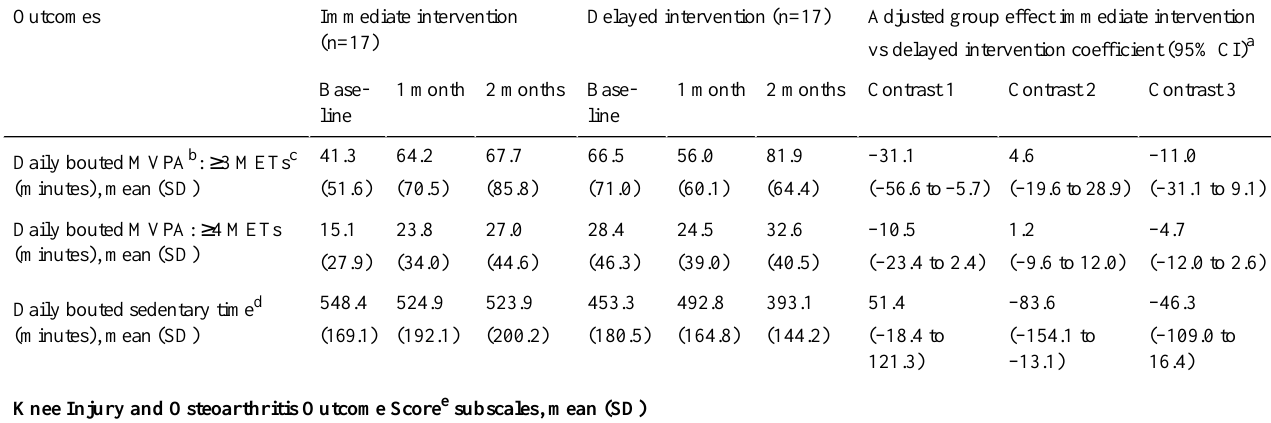
Table 3. Participant outcomes and results of contrast